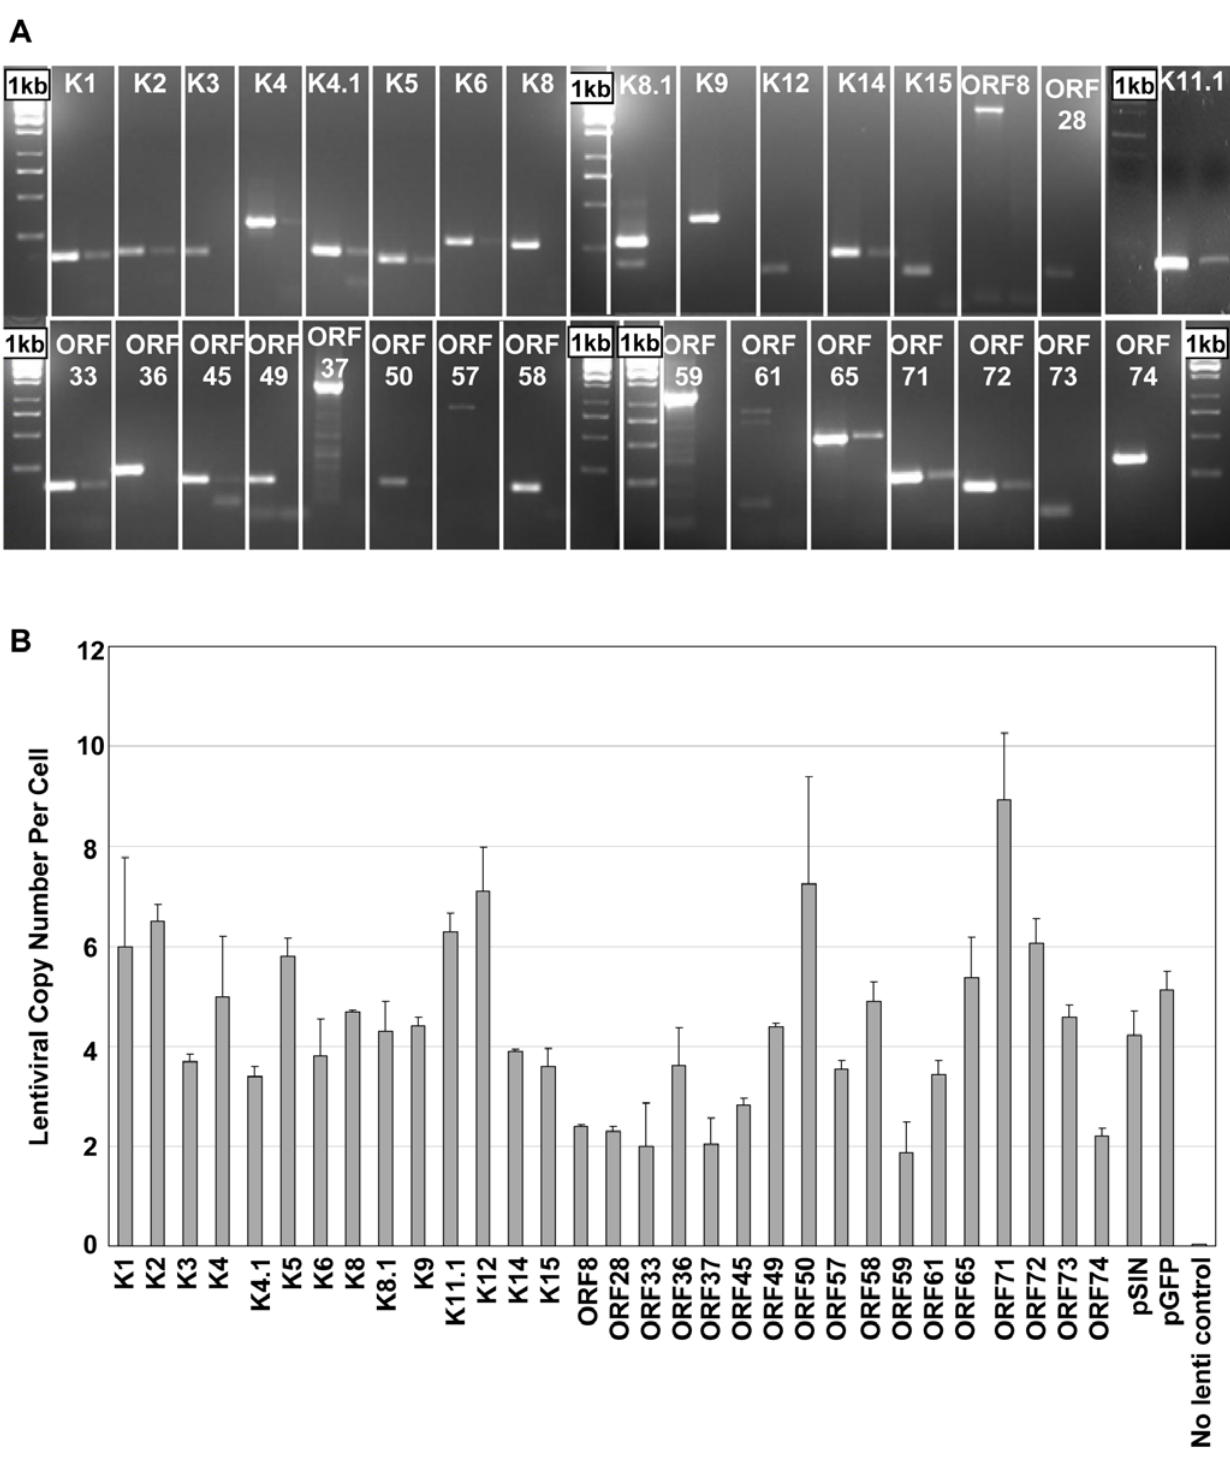
Figure 2. Expression and multiplicity of infection in moDCs of each of the KSHV-gene-encoding lentiviruses. (a) KSHV ORF expression by mature moDCs 6 days after transduction with KSHV-gene-encoding lentiviruses. For each ORF, the left-hand lane shows the reverse transcription (RT)-PCR product and the right-hand lane shows the no reverse transcriptase control. (b) Multiplicity of Infection (MOI) of each of the KSHV-gene- encoding lentiviral preparations in one experiment. Average lentiviral copy number per cell and standard deviations of duplicates are shown.